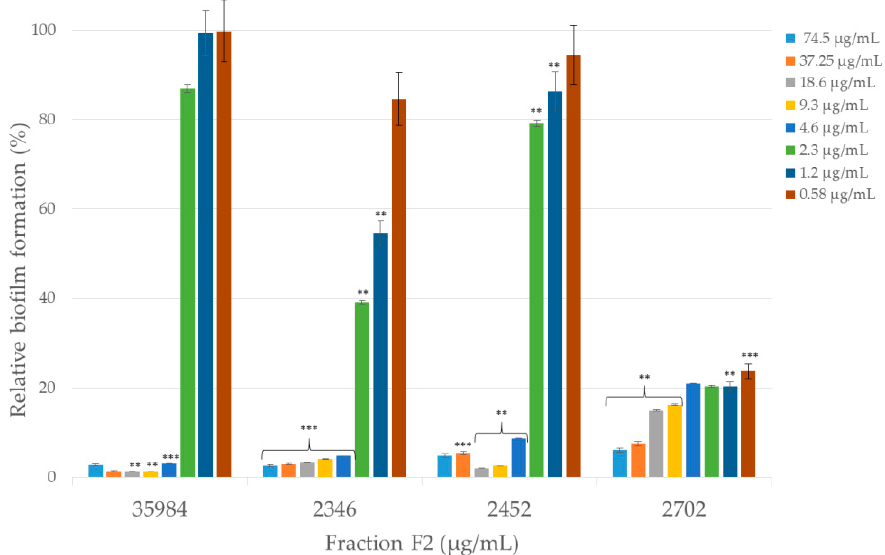
Figure 8. Anti-biofilm activities of fraction F2 against standard S. epidermidis (ATCC 35984) and clinical strains (2346, 2452, 2702). Fraction F2 occurred in two-fold decreasing concentrations (74.5, 37.25, 18.6, 9.3, 4.6, 2.3, 1.2, and 0.58 µ g / mL) for each bacterial strain. The error bars and asterisks represent the standard errors and statistical significance with the p -values: *** p < 0.001, ** p <